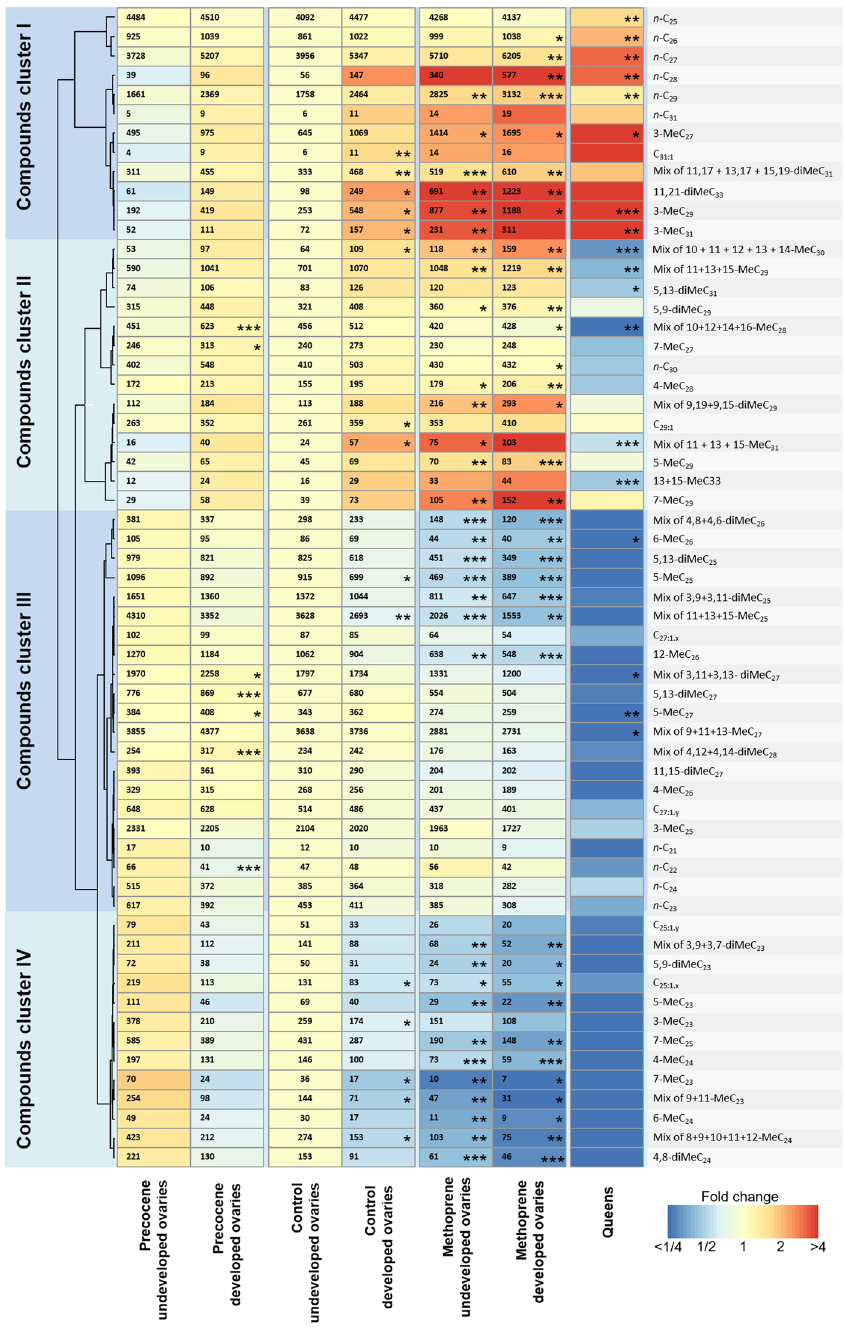
Figure 1. Heatmap showing JH-induced changes in cuticular hydrocarbon profiles. Effect of treating workers with the JH-analog methoprene and the JH inhibitor precocene-I on cuticular hydrocarbon profiles and known queen and fertility signals. Colors indicate the fold difference in relative abundance of each CHC peak compared to control workers with undeveloped ovaries. Hence, a value of two implies that the relative abundance of a given compound would be twice as high as in the reference acetone solvent control group. Columns of the heatmap correspond to the different treatments, which were split up by observed ovary development. The compound cluster analysis was based on a UPGMA hierarchical clustering using one minus the Pearson correlation as the distance metric. Values indicate mean absolute quantities per worker in ng and asterisks indicate significance levels for the following contrasts: control developed vs control undeveloped, precocene developed vs control developed, precocene undeveloped vs control undeveloped, methoprene developed vs control developed, methoprene undeveloped vs control undeveloped and queens vs methoprene developed, derived from a LMM with Benjamini & Yekutieli 82 FDR p value correction: * p < 0.05, ** p < 0.01, *** p < 0.001. For detailed statistical results see Supplemental Table